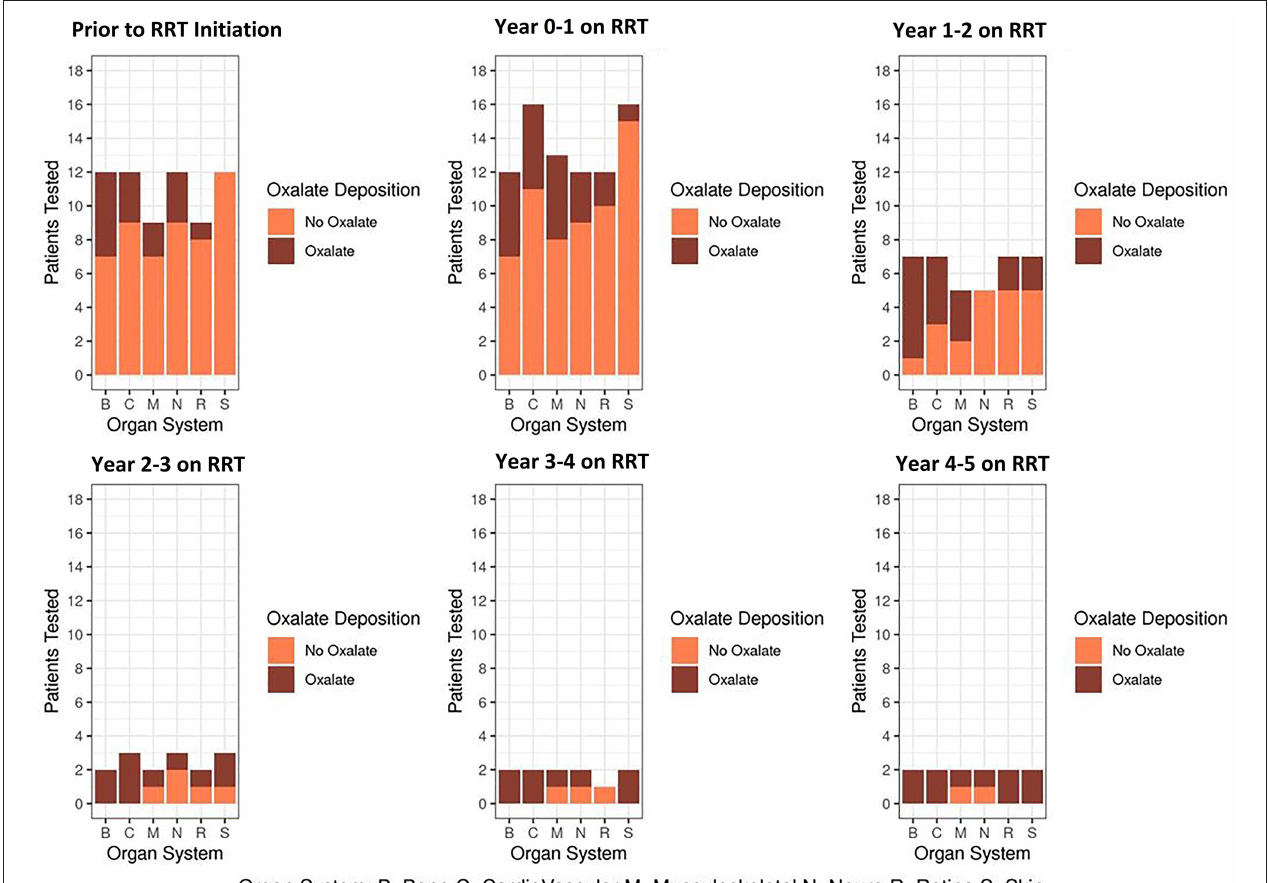
FIGURE 4 | Clinical evidence of oxalosis over time on